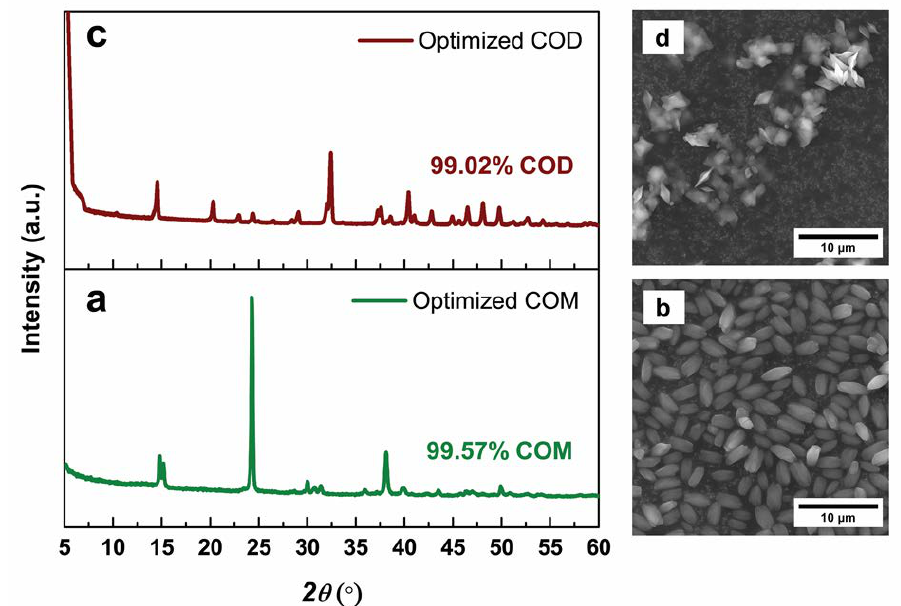
Figure 6. XRD diffractograms of the samples ( a ) COM, and ( c ) COD obtained under optimal conditions; SEM images of ( b ) COM obtained under optimal conditions, and ( d ) COD obtained under optimal conditions.